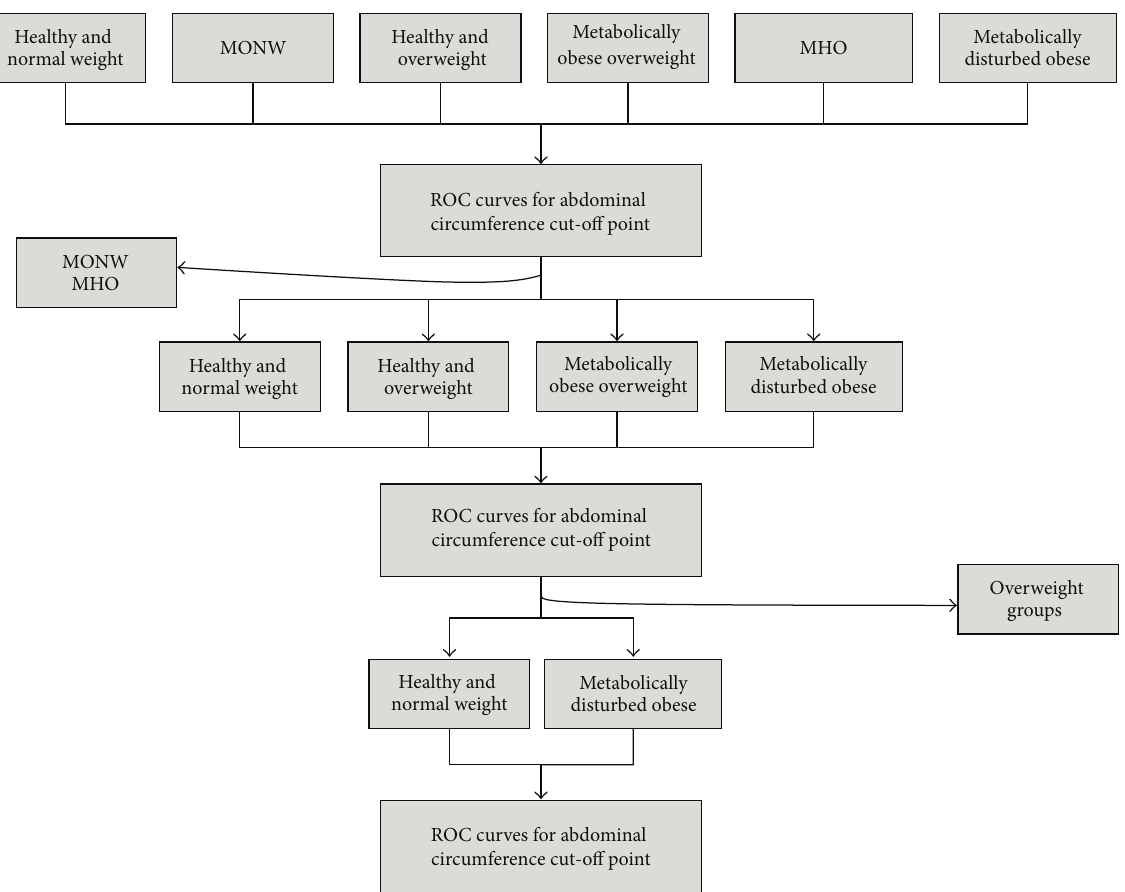
Figure 2: Diagram that depicting the selection process during the phenotype analysis and exclusion to determine the proper cut-off point for